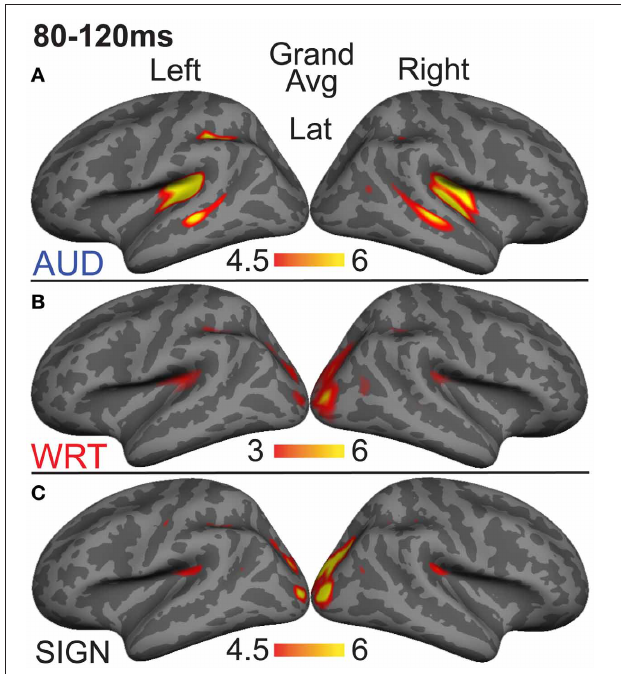
FIGURE 3 | Grand average group dSPMs during the early encoding time window from 80 to 120ms. (A) Auditory words (“AUD”) show strong responses in bilateral PT and STS. (B) Written (“WRT”) and (C) signed (“SIGN”) words show sensory processing at the occipital pole. F -values on the color bars represent signal-to-noise